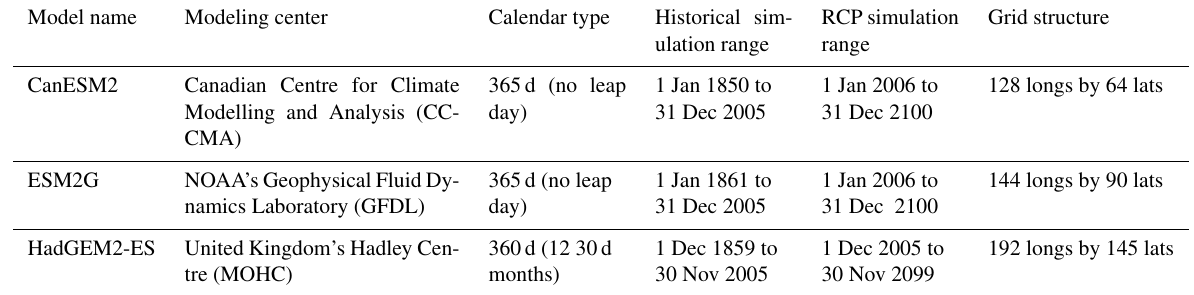
Table 2. The grid structure and temporal extents of each of the three GCMs utilized in this